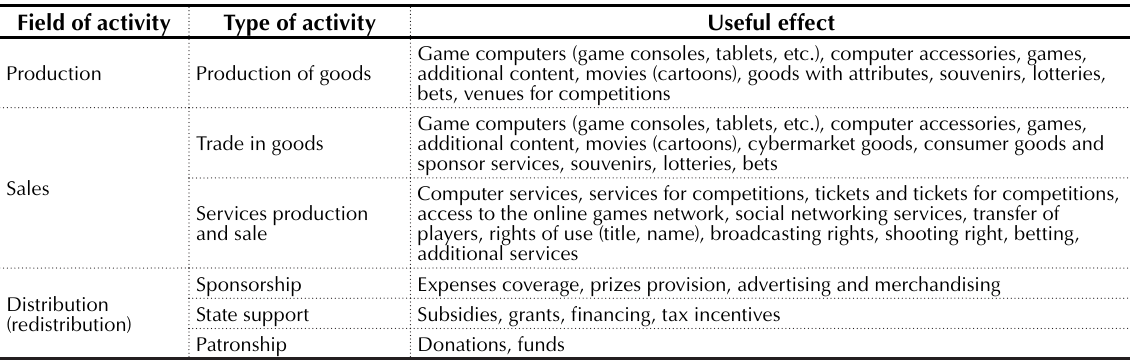
Source: Compiled by authors.